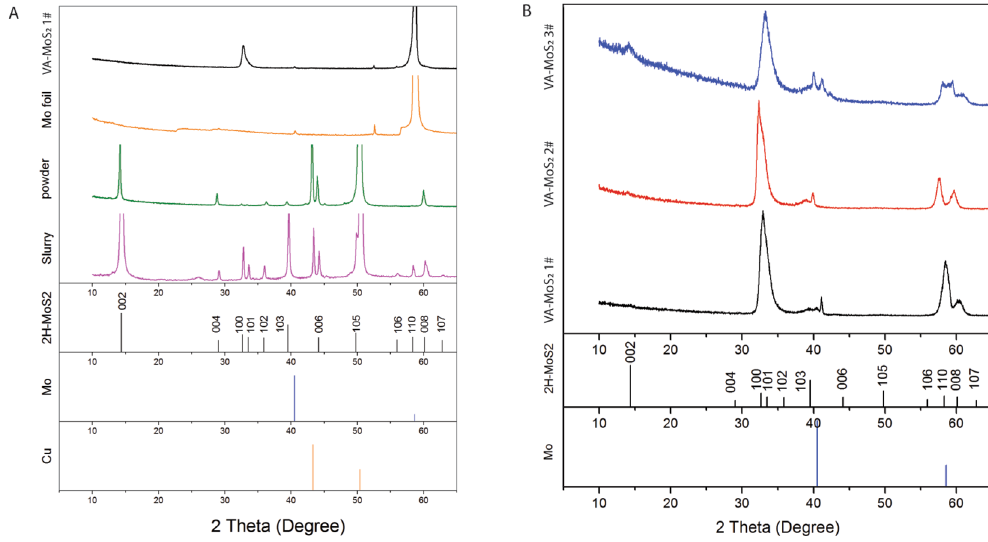
Figure 5. X-Ray diffraction (XRD) patterns of MoS 2 films in slurry on Cu, PO-MoS 2 on Cu and VA-MoS 2 #1 on Mo ( A ); Grazing incidence-XRD (GIXRD) of CVD-grown samples ( B